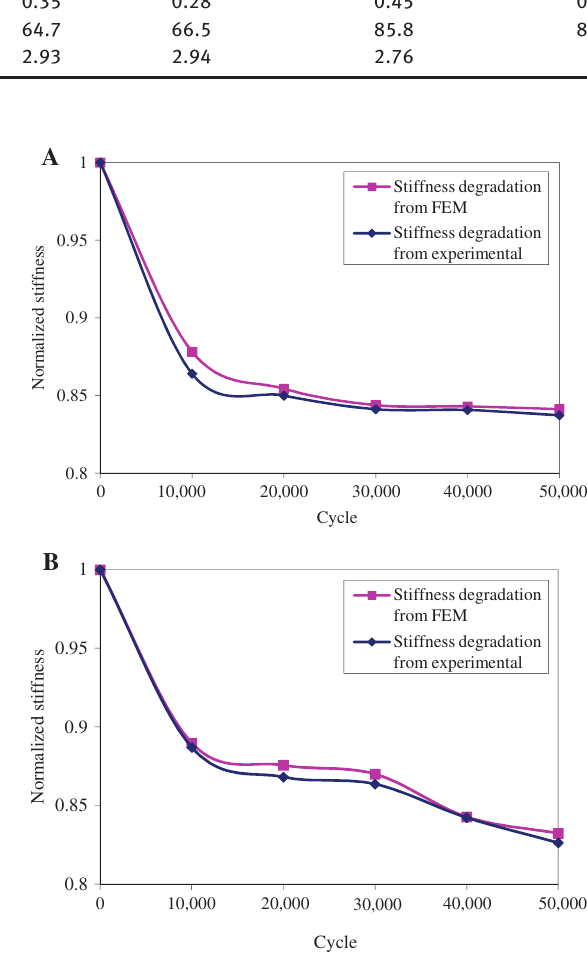
Figure 12: Normalized stiffness versus number of load cycles for (A) RC beams and (B) CFRP-retrofitted RC